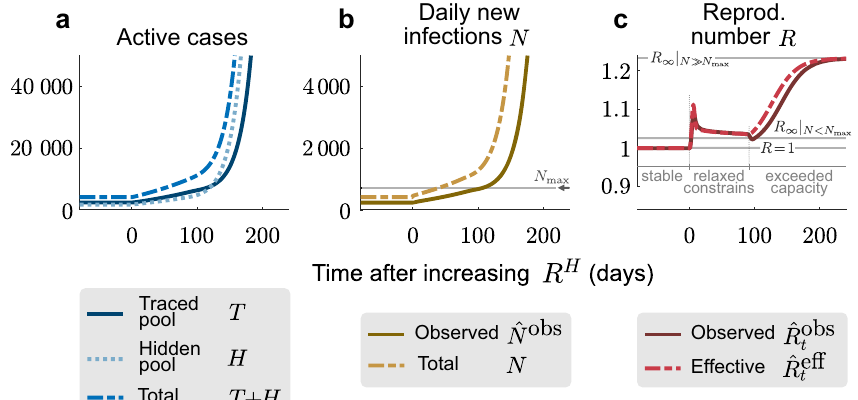
Fig. 6 A relaxation of restrictions can slowly overwhelm the fi nite tracing capacity and trigger a new outbreak. a At t = 0, the hidden reproduction number increases from R H t ¼ 1 : 8 to R H t ¼ 2 : 0 (i.e., slightly above its critical value). This leads to a slow increase in traced active cases (solid blue line). b When the number of observed new cases (solid brown line) exceeds the tracing capacity limit N max (solid gray line), the tracing system breaks down, and the outbreak starts to accelerate. c After an initial transient at the onset of the change in R H t , the observed reproduction number (solid red line) faithfully re fl ects both the slight increase of the hidden reproduction number due to relaxation of contact constraints, and the strong increase after the tracing capacity (solid gray line) is exceeded at t ≈ 100. In both cases, the observed reproduction number ^ R obs t approaches two different limit values R ∞ , which are derived from a linear stability analysis (further details in Supplementary Fig. 5). All the curves plotted are obtained from numerical integration of Eqs. (1) –